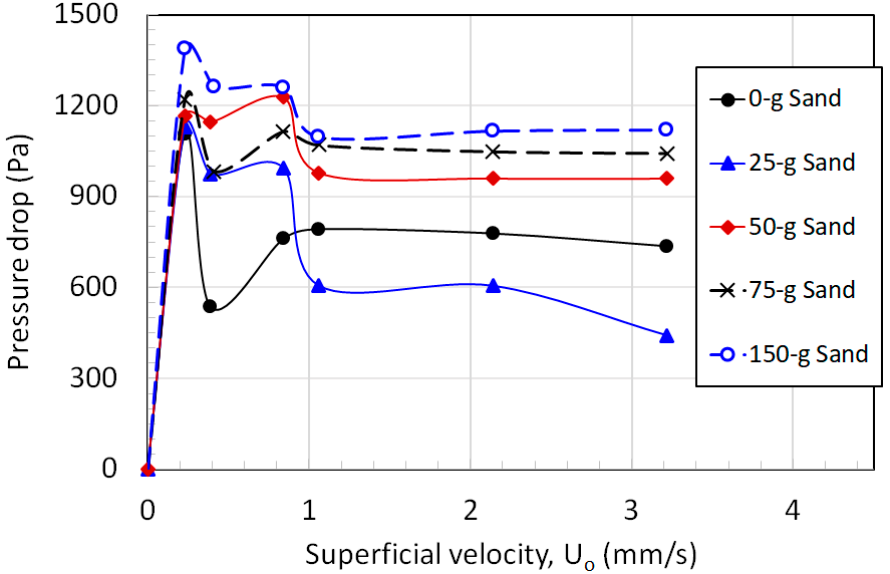
Figure 11. Effect of velocity and particle mixing on the pressure drop profile of a bed of activated carbon during fluidization at ambient conditions using nitrogen gas.